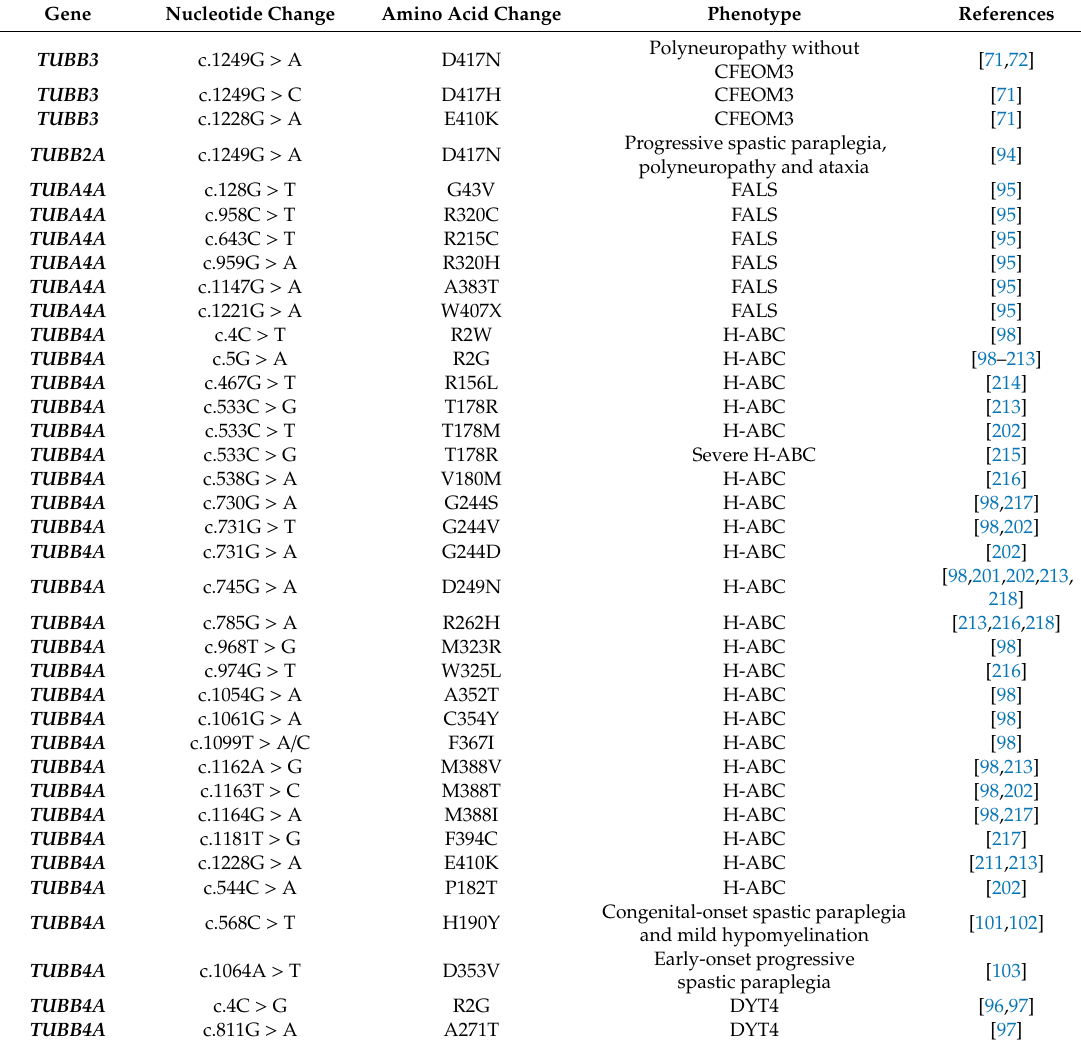
Table 1. List of tubulin mutations causing neurodegenerative